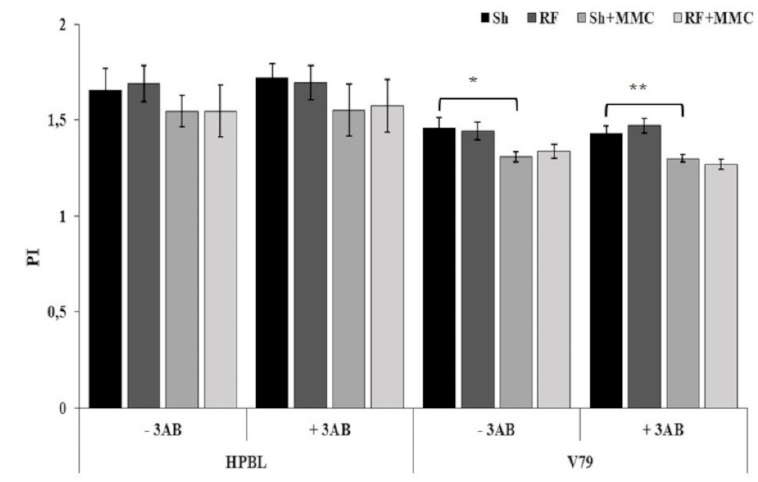
Figure 3. Cytotoxicity, expressed as the proliferation index (PI), in 1000 HPBL and V79 cells. For each cell type, results of Sh, RF, Sh + MMC, and RF + MMC treatments are reported, in the absence and in the presence of 3AB. Each data point represents the mean ± SD of three independent experiments.